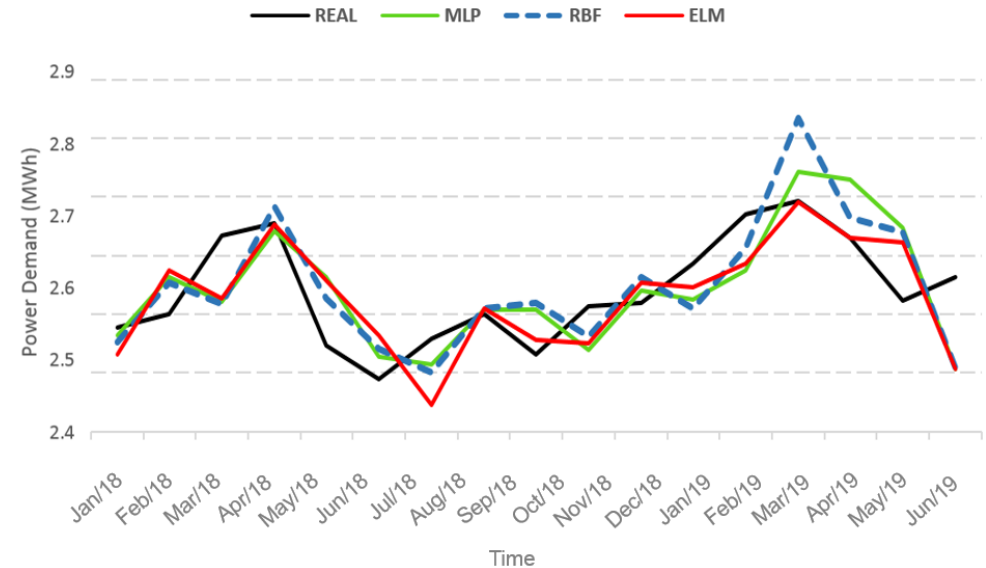
Figure 10. Graph comparing actual data with data predicted for three steps ahead, using MLP, RBF, and ELM.